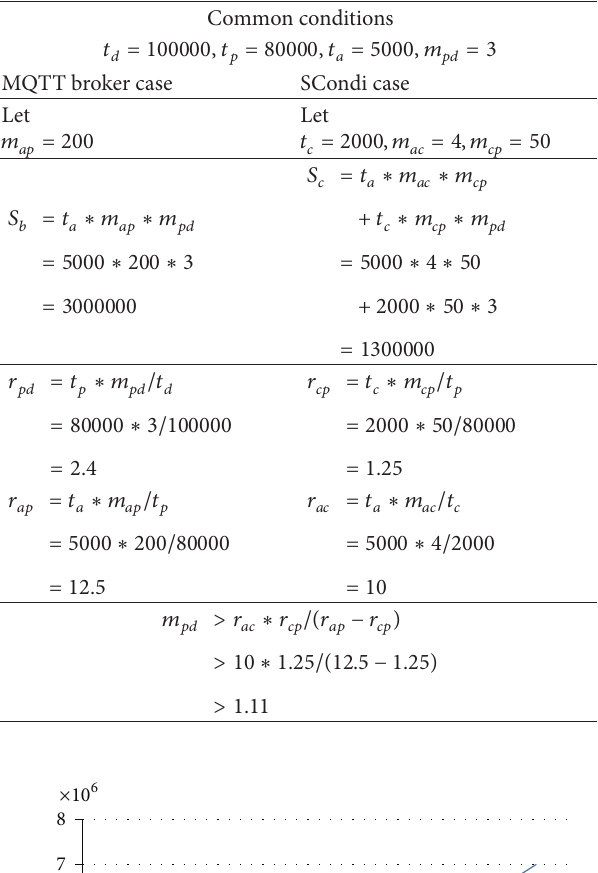
Table 3: Example of delivered message comparison with practical data.